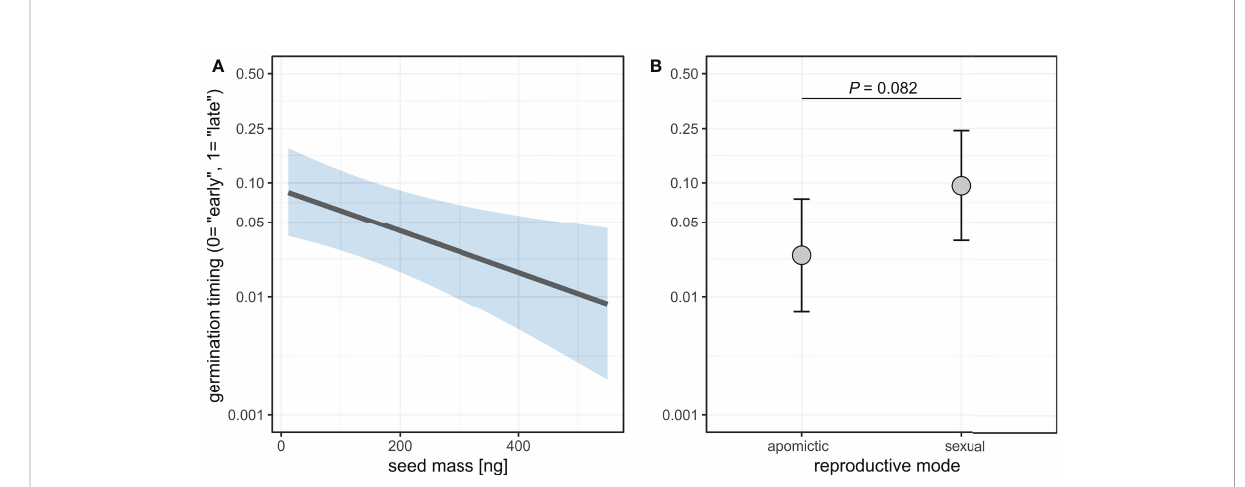
FIGURE 9 Effects of seed mass (A) and reproductive mode (B) on germination timing ( “ early ” vs . “ late ” germination). Germination probability is plotted on a logit scale. Shaded area (A) and error bars (B) represent 95% con fi dence intervals.